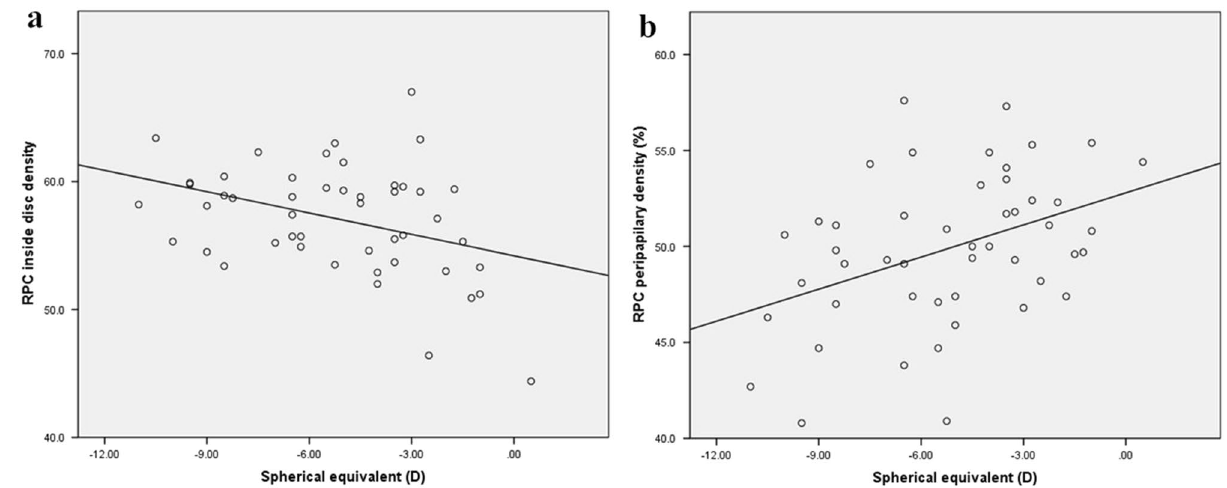
Figure 3. The association between spherical equivalent with vessel density inside the disc and in the papillary area ( a ) inside the disc, ( b ) the peripapillary area. D: diopter; RPC: radial peripapillary capillary.